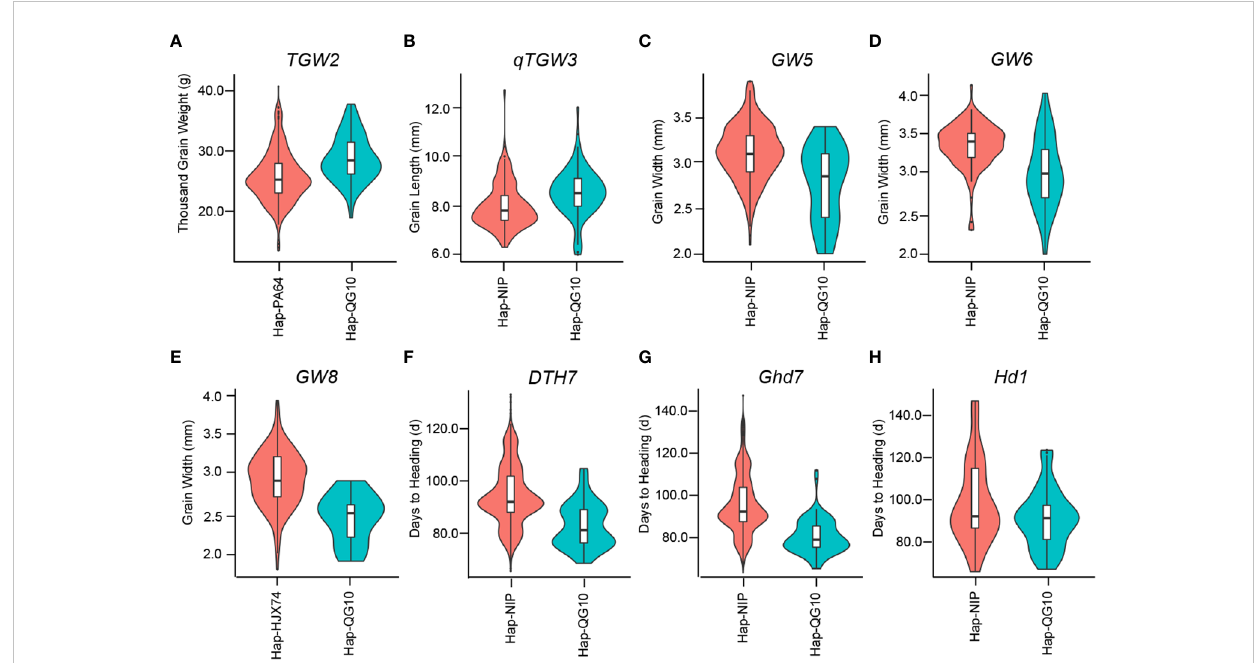
FIGURE 8 Comparison of grain shape traits and days to heading between different gene haplotypes in 3k